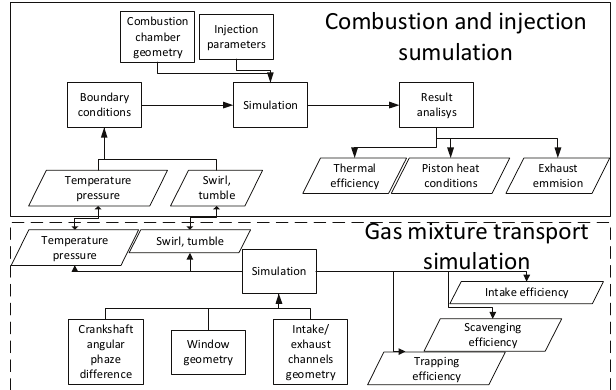
Fig. 1. Information flow diagram for engine work cycle optimization